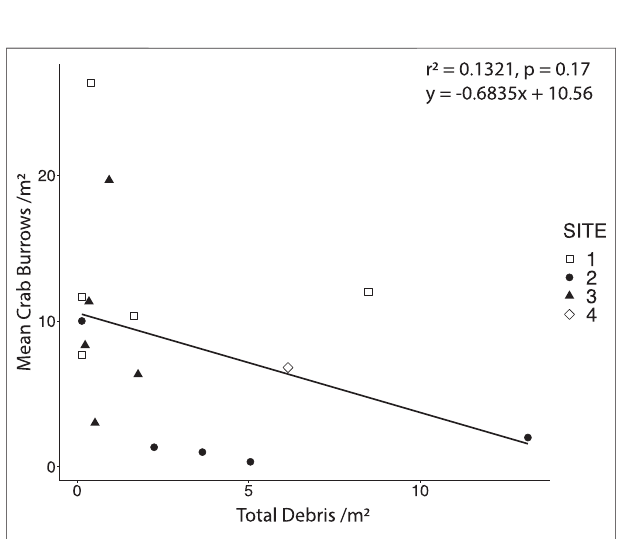
FIGURE 6 | A scatter plot with the total number of debris items per m 2 plotted on the x -axis and the number of crab holes per m 2 plotted on the y -axis. A trendline for a linear regression is shown with the equation, R 2 value, and p value denoting signi fi cance.